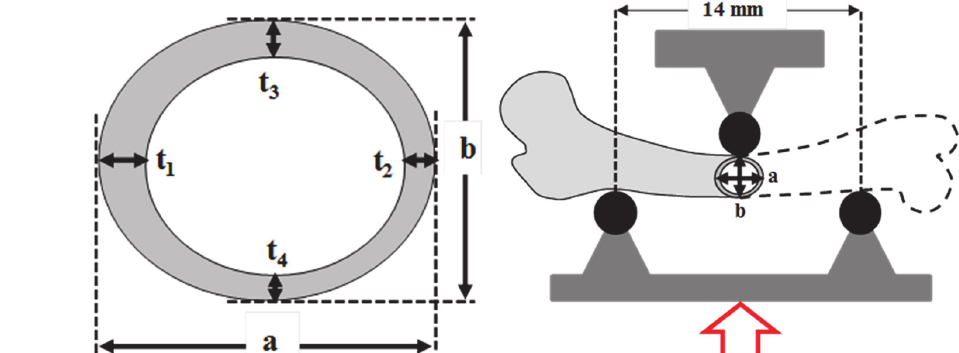
Figure 2: A schematic representation of the three point bending test. The measurement sites for thickness (t 1-4 ) and lengths of the major (right) and minor axis (left) of the samples are also